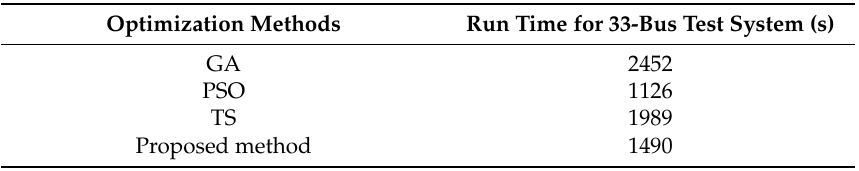
Table 6. The run times of the proposed method and other optimization methods to solve the multiyear network expansion planning problem on 33-bus distribution